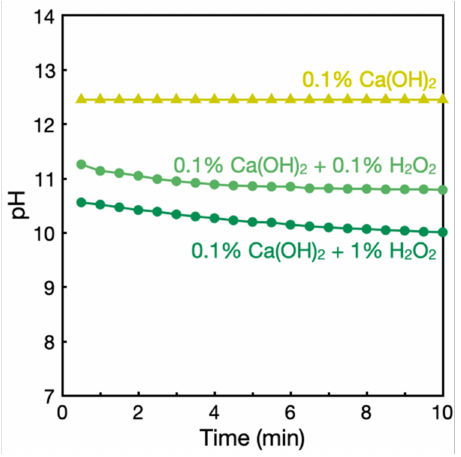
Figure 5. pH time courses of the solutions of Ca(OH) 2 and H 2 O 2 .